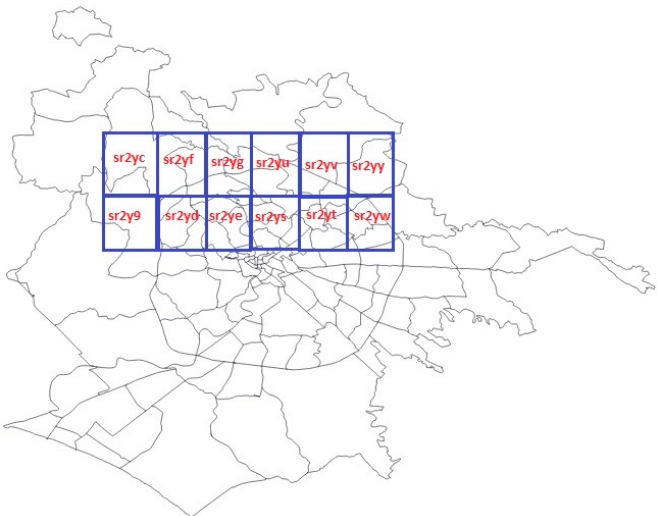
Figure 1. Partial view of the geohash covering near the city center of Rome in Italy. Geohash precision is 25 (i.e., 5 characters). Mobility data traces that are nearby by certain distance are enclosed within the boundaries of the same geohash area; thus, have the same geohash index value. Several geohash values cover a specific neighborhood. This is known as the geohash covering. Edge cases occur in the situation where several points share the same geohash value despite belonging to different neighborhoods. Those cases are resolved by applying the spatial join operator.